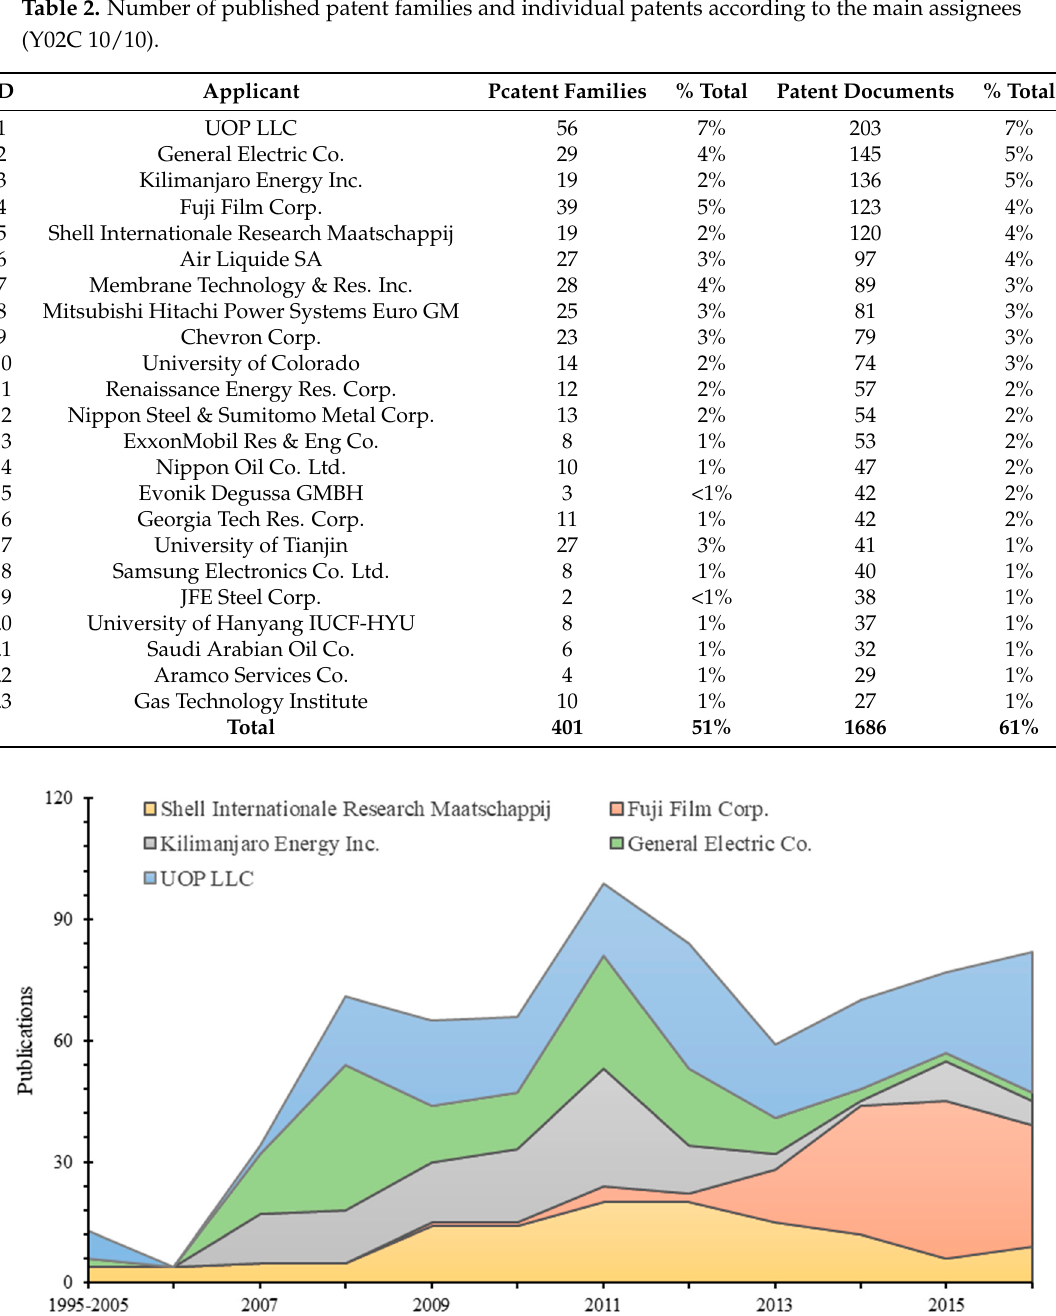
Table 2. Number of published patent families and individual patents according to the main assignees (Y02C 10/10).